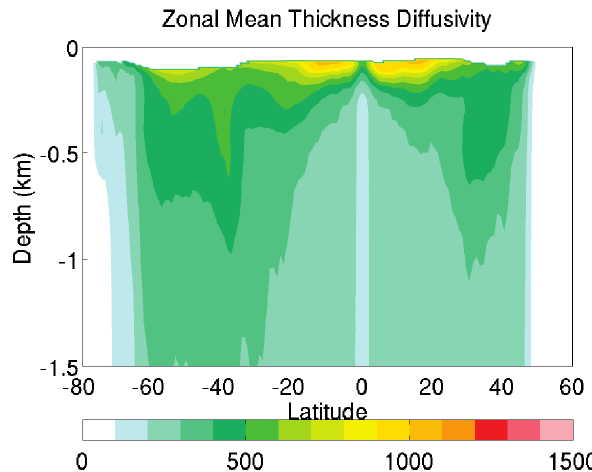
Fig. 116. Zonal mean temporal mean thickness diffusivity [ m 2 s (cid:0) 1 ]. Fig. 16. Zonal-mean temporal mean thickness diffusivity (m 2 s − 1 ). The mean surface boundary layer region is not plotted. The results The mean surface boundary layer region is not plotted. The results are the last 10 yr mean in a 60 yr simulation. are the last 10yr mean in a 60yr